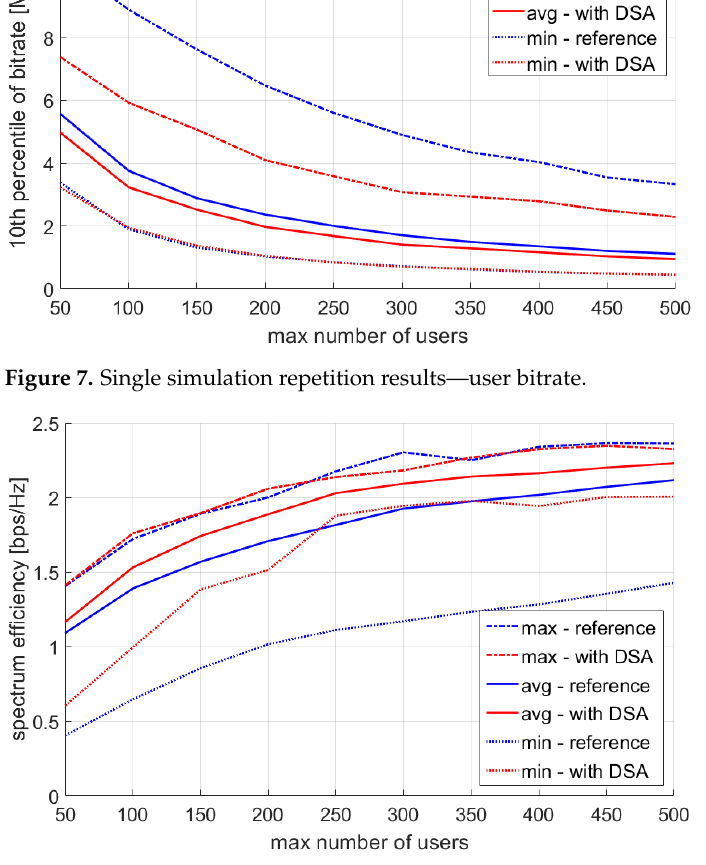
Figure 8. Single simulation repetition results—spectral efficiency.